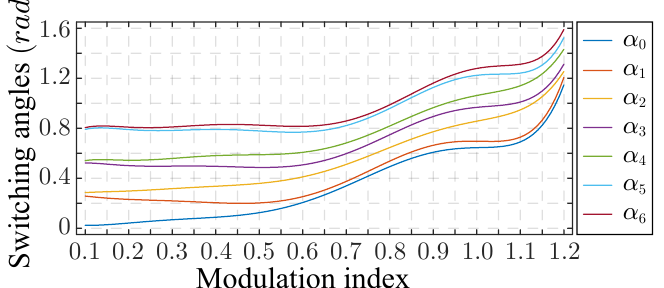
Figure 4. Switching angle solution set applying the EMA with shareholder population size equal to 50 for the SHM problem with seven switching angles considering a wide range of modulation indexes from 0.1 to